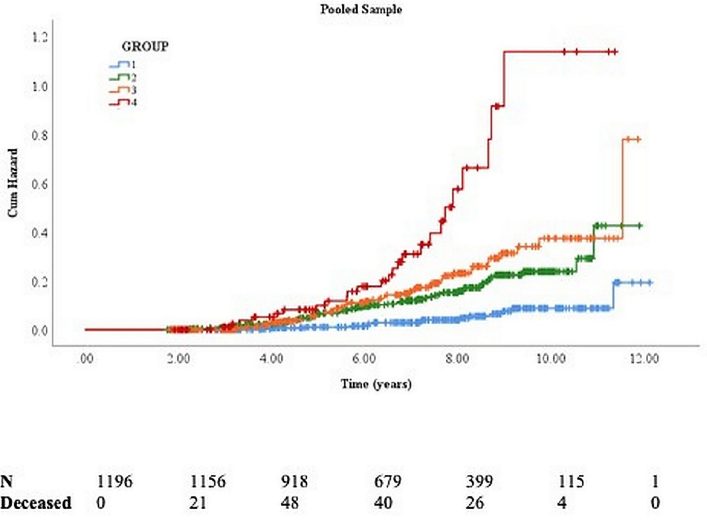
Fig 3. Survival plots show the cumulative risk of mortality based on frailty trajectories in the pooled LonGenity and Einstein Aging sample. Group 1 (relatively stable–reference group), 2 (mild frail), 3 (moderate frail) and 4 (severely